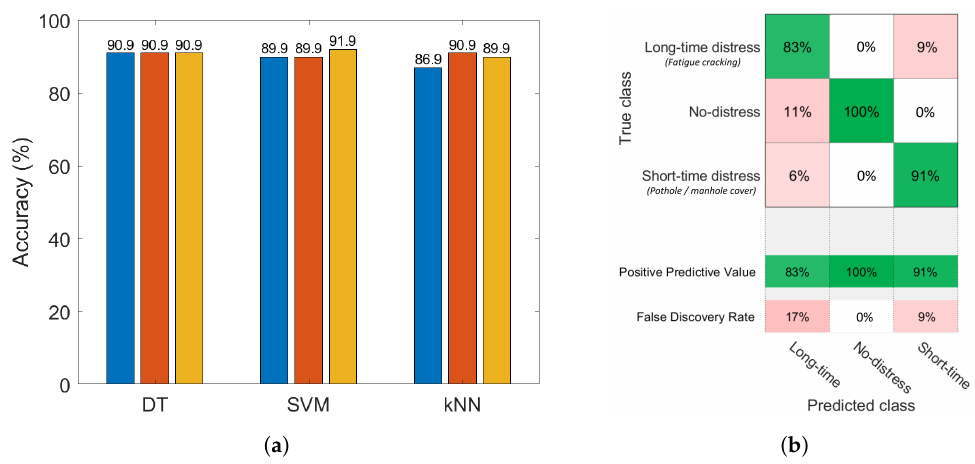
Figure 10. Classification results based on data collected from the car’s dashboard; predictive accuracy of the considered supervised learning classification families: DT (2, 5, 10 splits), SVM (linear, quadratic, cubic kernels), k NN (1, 10, 30 neighbors) ( a ); confusion matrix for the cubic SVM classifier ( b